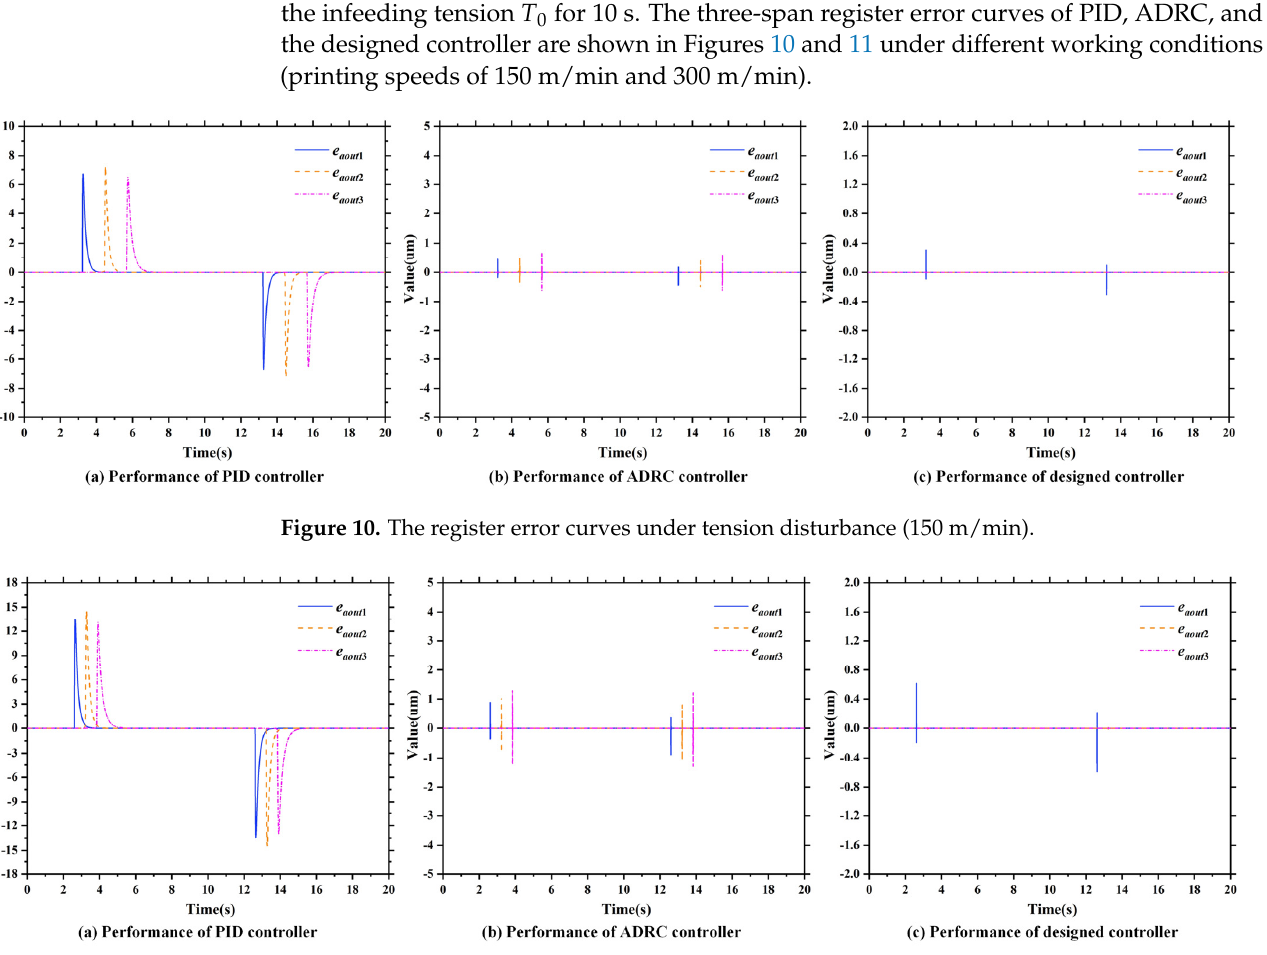
Figure 11. The register error curves under tension disturbance (300 m/min).